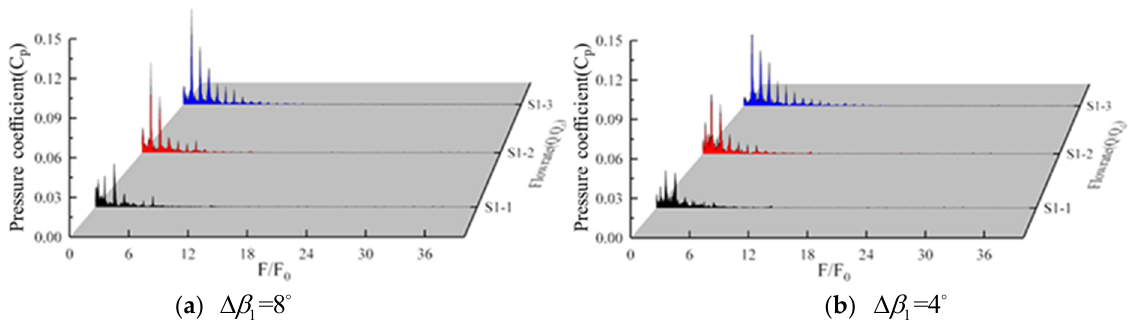
Figure 18. Frequency domain characteristics of monitoring points at suction surface of blade when 0.5Q.